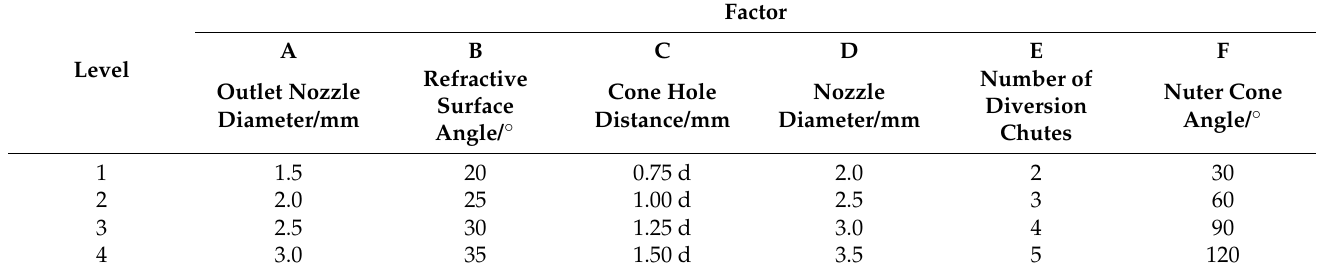
Table 4. Nozzle structural parameters. “d” is Outlet nozzle diameter.